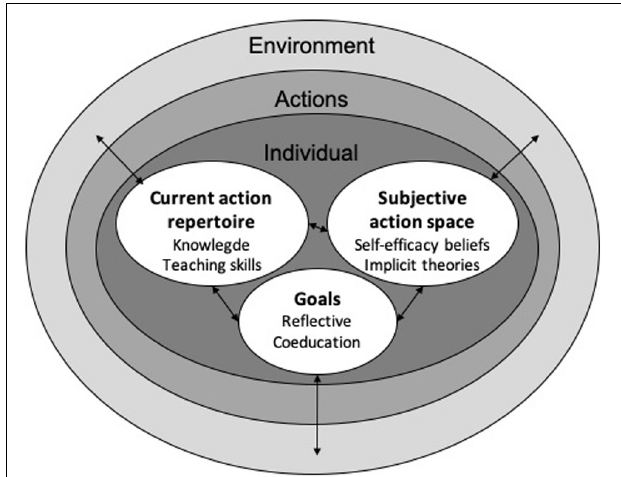
FIGURE 1 | The actiotope